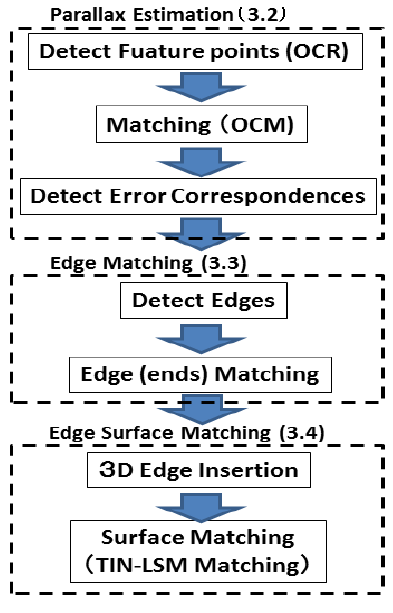
Figure 2. Flowchart of the Extended Edge TIN-LSM